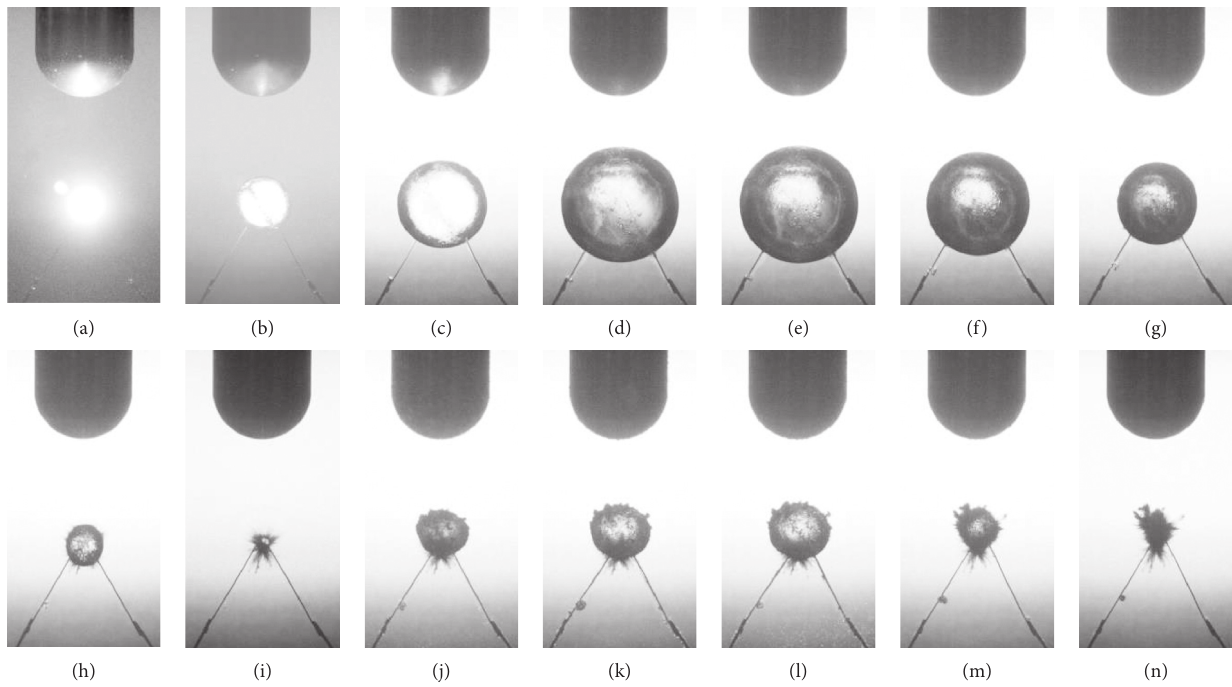
Figure 22: Diagram of bubble dynamics under the influence of hemispheric boundary for c � 2.0: (a) 0.000ms, (b) 0.416ms, (c) 1.041ms, (d) 2.458ms, (e) 3.208 ms, (f) 4.416 ms, (g) 5.082ms, (h) 5.624ms, (i) 5.749 ms, (j) 6.249ms, (k) 6.707 ms, (l) 7.124ms, (m) 8.207ms, and (n) 8.457ms.